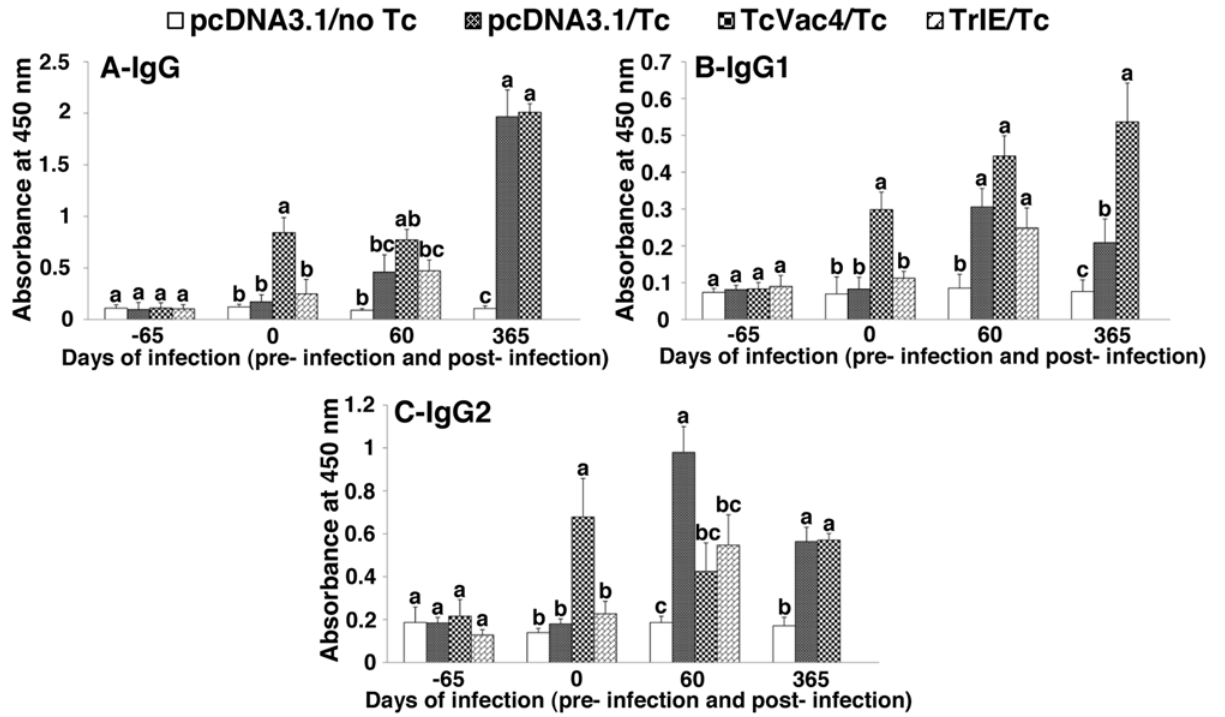
Fig 1. TcVac4-induced antibody response in dogs ( ± T . cruzi ). Dogs were vaccinated with TcVac4 or TrIE only and infected with T . cruzi , as described in Materials and Methods. Shown are sera levels of T . cruzi -specific IgG (A) , IgG1 (B) , and IgG2 (C) antibody subtypes, determined by an ELISA. Dogs given pcDNA3.1/no infection and dogs given pcDNA3.1/ T . cruzi were included as negative and positive controls, respectively. The serology time points are described as day -65 = basal response before immunization, day 0 representing antibody response after last immunization but before challenge infection, day 60 post challenge equivalent to acute infection phase, and day 365 post challenge equivalent to chronic disease phase. Each bar represents the absorbance mean value ± standard deviation. Within the same time point, statistical differences (p < 0.05) among groups are shown with different characters above the bars according to Tukey ’ s